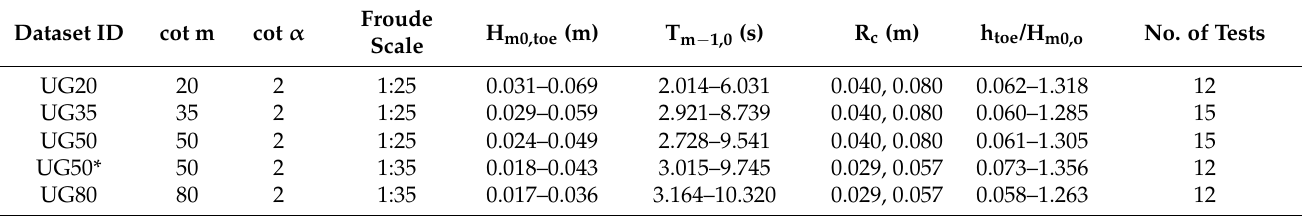
Table 2. Characteristics of the UGent dataset, grouped per foreshore